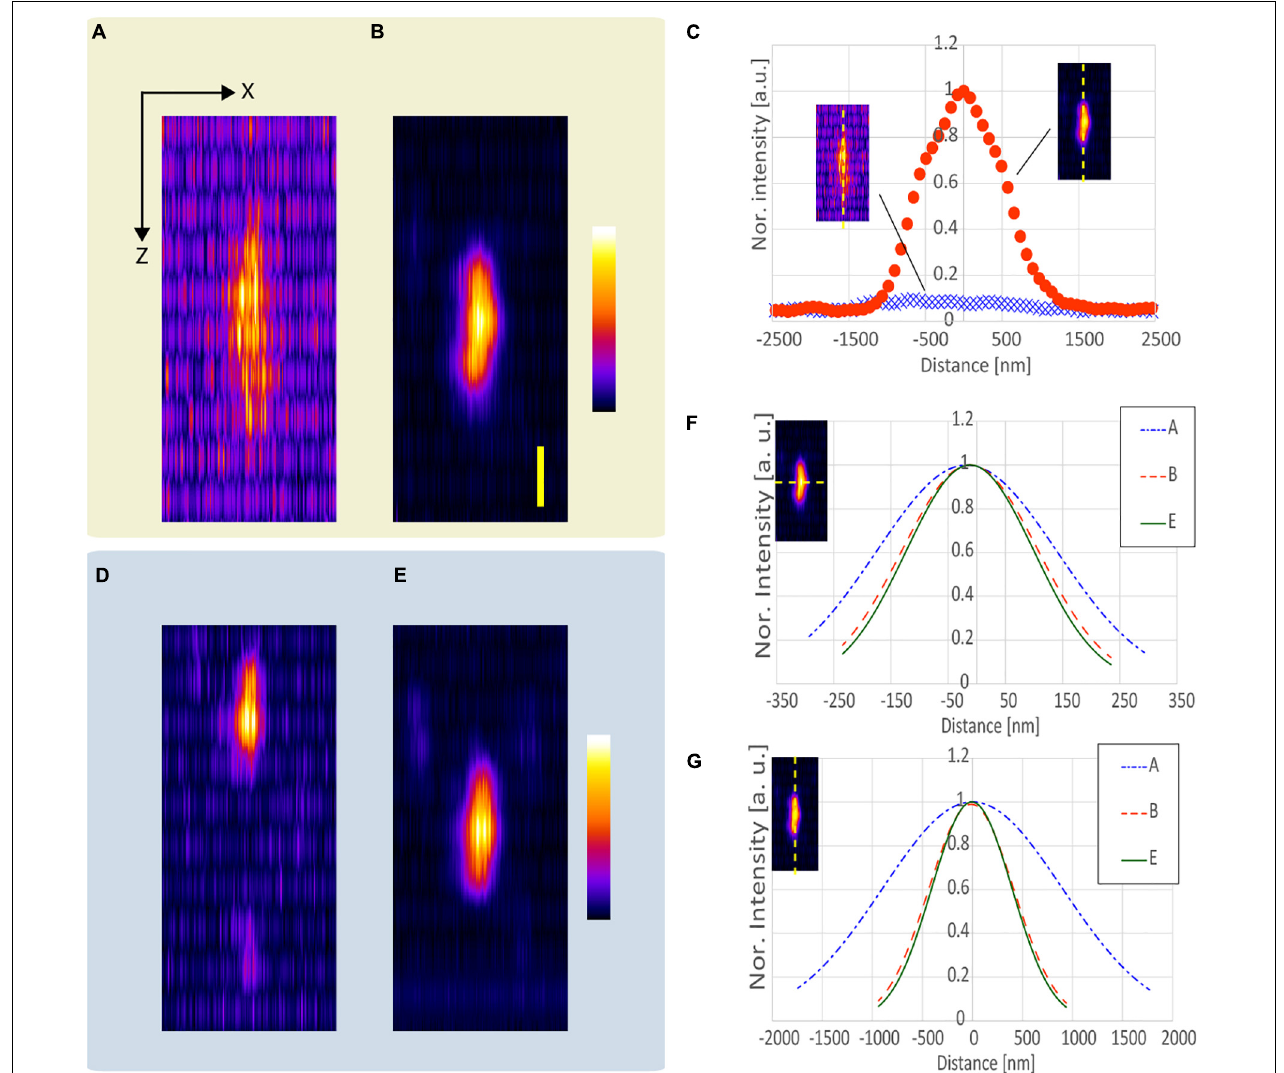
FIGURE 5 | Observation results of a fluorescent nanodiamond existing at an optical depth of 53.7–57.1 µ m. The x-z projected images of the nanodiamond obtained using the APV, (A) without and (B) with SA correction. (C) Axial profile of the nanodiamond obtained using the APV excitation beam with and without SA correction. The x-z projected images obtained using the AMAPV excitation beam (D) without and (E) with SA correction. (F) Gaussian fitting results in the lateral direction. (G) Gaussian fitting results in the axial lateral direction. The excitation beam intensity under the objective lens was (A,B) 38.7 and (D,E) 69 mW. Scale bar: 500 nm.